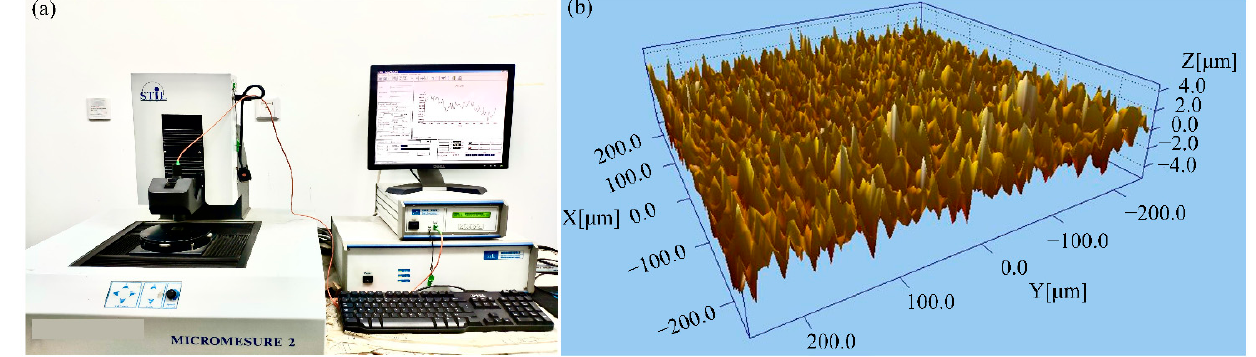
Figure 1. Measurement of gear tooth surface: ( a ) 3D surface profiler (STIL-MICROMESURE 2); ( b ) gear surface topography.